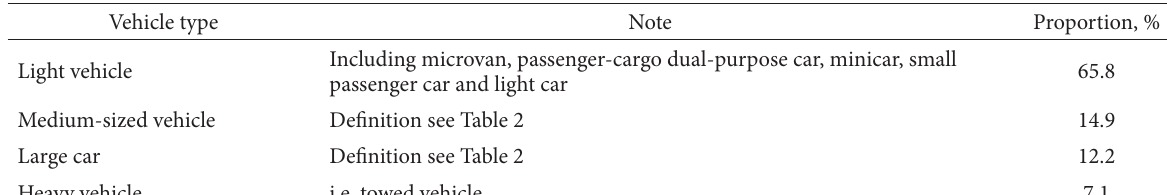
Table 3. Vehicle composition of the Pingsheng Bridge